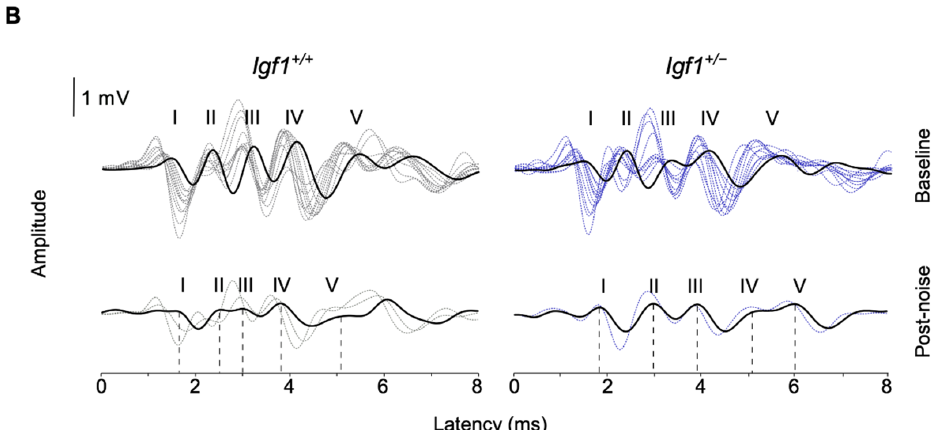
Figure 2. Differential response to noise damage in Igf1-heterozygous mice as they age. ( A ) Evolution of ABR threshold shifts (mean ± SEM) after noise exposure in young (n = 4 and 3) and adult (n = 9 and 7) Igf1 +/ − and WT mice, respectively. ABR was evaluated before (baseline) and 1 h and 14 and 28 days post-noise exposure in young mice. In adult mice, ABR was evaluated before (baseline) and 3, 14, and 28 days post-noise exposure. Statistically significant differences were analyzed by Student’s t -test between genotypes (* p < 0.05, ** p < 0.01, *** p < 0.001). Electrical responses to broadband clicks and 8, 16, 20, 28, and 40 kHz pure tone stimuli, with an intensity range of 90–20 dB SPL in 5–10 dB steps, were recorded. ( B ) Representative ABR recordings in response to the click stimulus of adult WT and Igf1 +/ − mice before (baseline) and 3 days after noise exposure; the solid black line marks the 10–20 dB SPL level above the auditory threshold where peak latencies were analyzed.